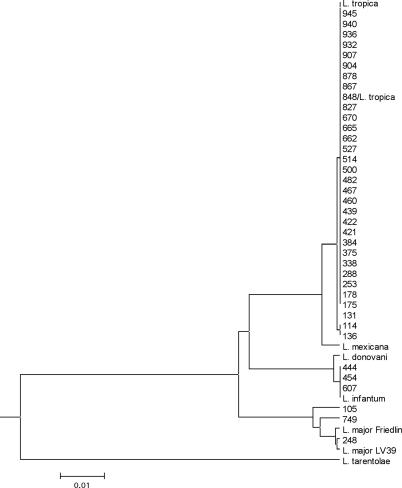
Phylogenetic Analysis of
Leishmania Isolates Responsible for ACL by Comparing the Sequences of
PTR1
The
PTR1 gene was sequenced in 31 Iranian isolates and control
L. major cells (LV39; Friedlin),
L. donovani 1S2D,
L. infantum (MHOM/67/ITMAP-263),
L. tropica
ATCC50129, and
L. tarentolae TarII. Strain 848 is identical, as determined by RAPD-PCR, to
L. tropica MHOM/IR/99, and strain 749 is identical to
L. major MHOM/IR/75/ER. Strains 444 and 454 were
Leishmania parasites isolated from dogs in Iran. The sequences were compared and clustered using the Molecular Evolutionary Genetics Analysis (MEGA3) software.